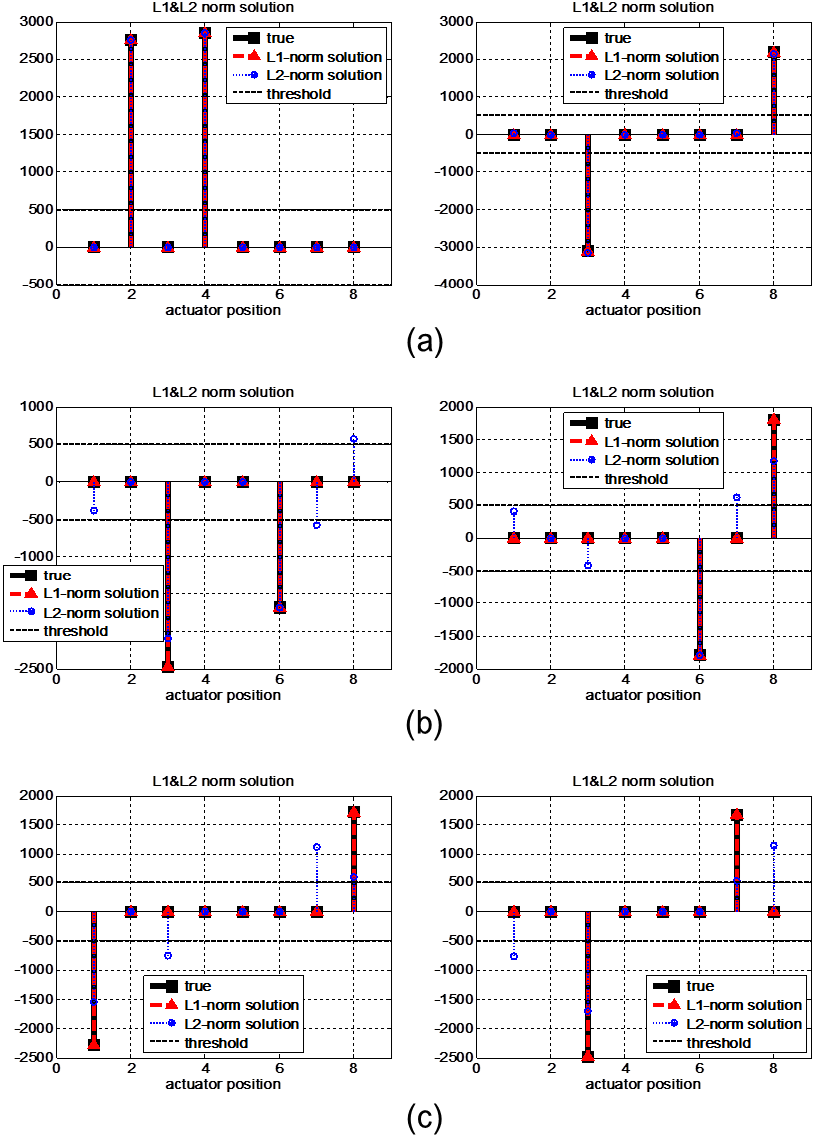
Figure 10. Two simultaneous fault isolation results obtained with the (cid:96) 1 -norm and (cid:96) 2 -norm mini- mization methods. The minimal (cid:96) 1 -norm solutions isolate the faults exactly for all represented cases, but minimal (cid:96) 2 -norm solutions represent ( a ) correct, ( b ) false alarm, and ( c ) false alarm & missed detection